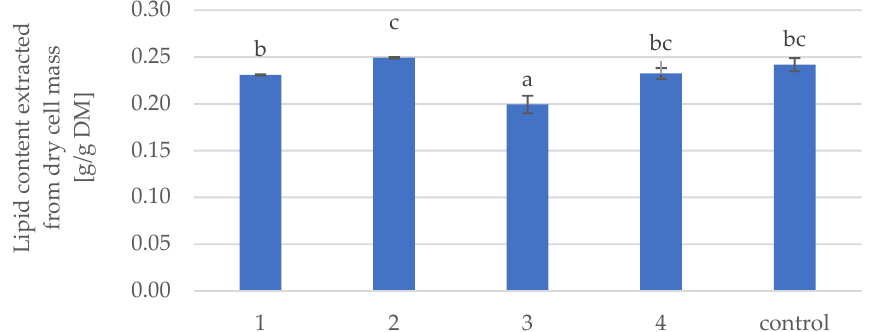
Figure 2. Average microbial oil content extracted using the Folch method from dried Y. lipolytica yeast biomass after high-pressure homogenization treatment according to parameters in Table 3. Homogeneous groups designated on the basis of Tukey’s test were identified by letters and different posts. Control is untreated yeast cells.